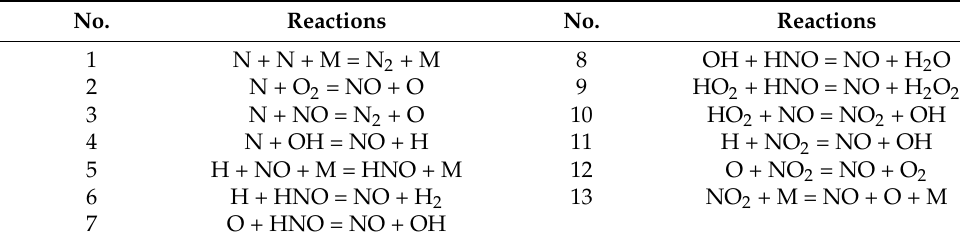
Table 3. Nitrogenous reactions within the Jachimowski scheme.